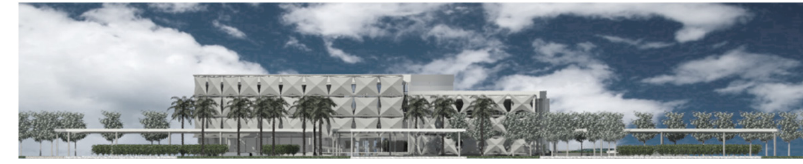
Figure 12. South elevation.